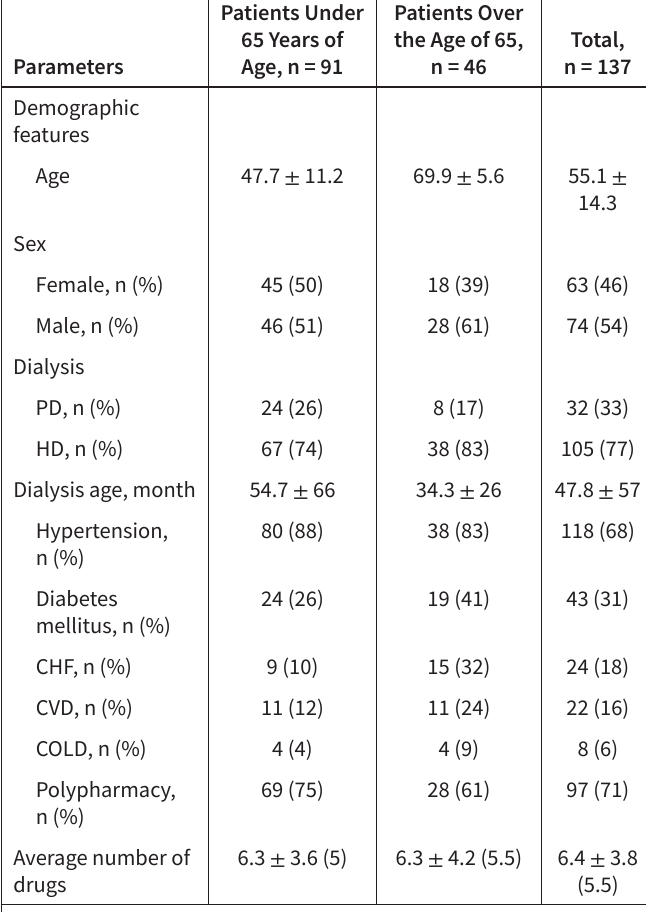
Table 1. Demographic Characteristics and Comorbidities of the Patients